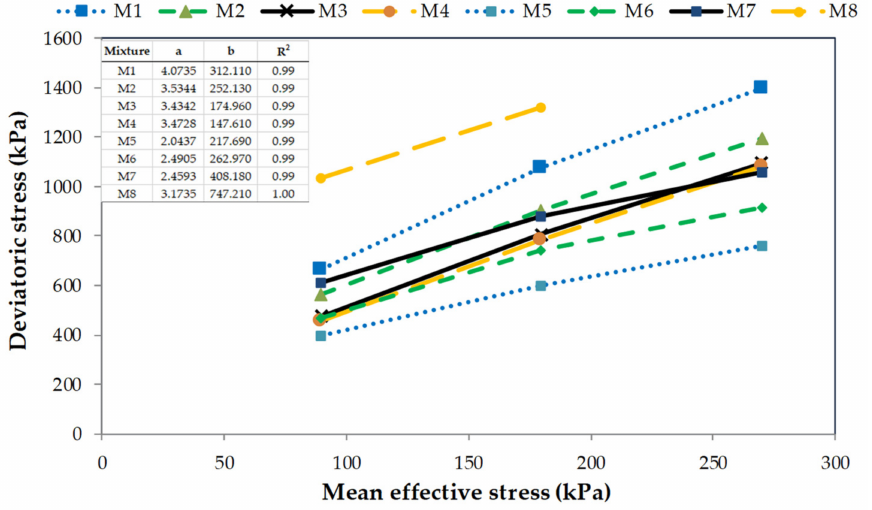
Figure 7. Deviatoric stress versus mean effective stress for all tested mixtures. A typical plot of the variation of the shear strain corresponding to peak shear stress at different confining pressure is shown in Figure 8. Due to the high deformation of the rubber waste particles, the magnitude of the shear strain at the peak deviator stress increases with the increasing proportion of rubber in the mixture. The highest values of the shear strain, regardless of the mean effective stress values, are observed for the M5 mixture, with 20% of rubber addition. As the rubber content of the specimen decreases by 5%, the strain decreases by an average of 8%. For the compositions without RTW, M1–M4, the shear strain decreases by about 50% for specimen M1 to about 25% for specimen M4.